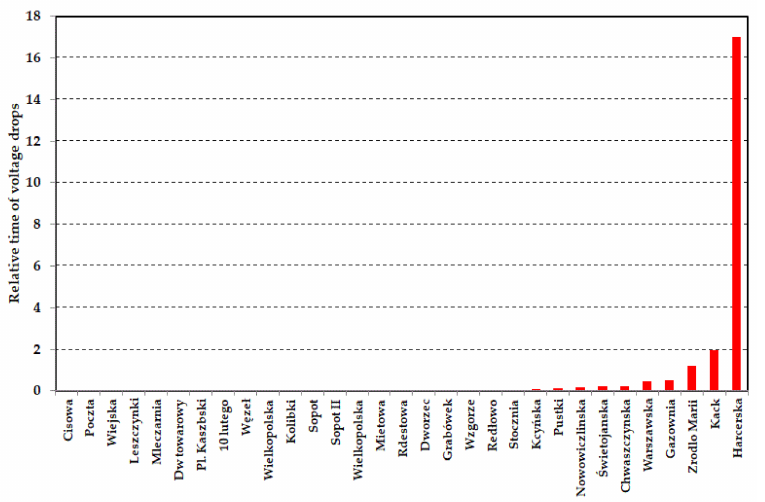
Figure 10. Relative time of voltage decrease below 500 V for particular power supply sections, expressed in per